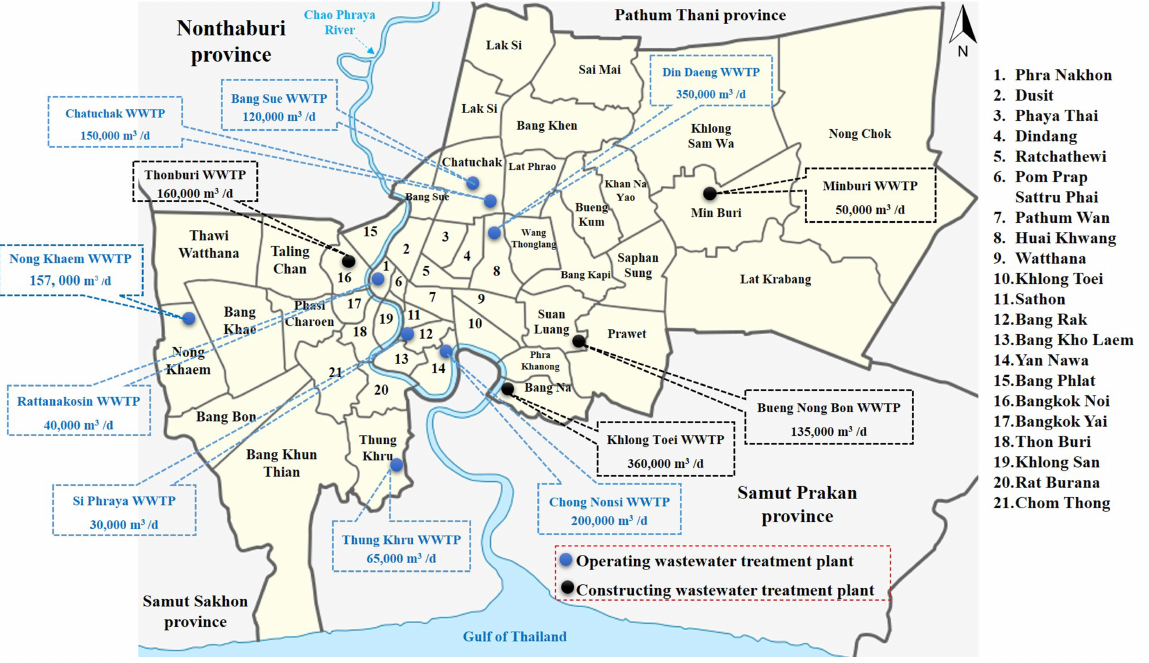
Fig. 5. Locations of BMA wastewater treatment